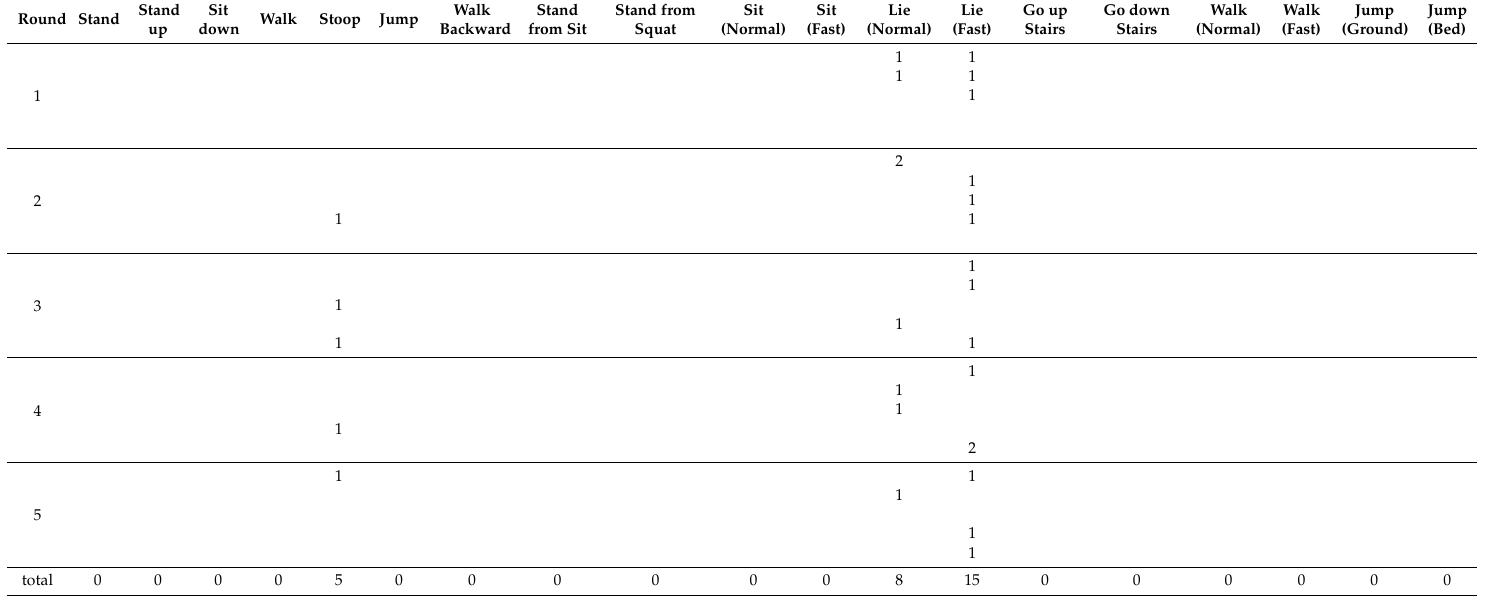
Table A2. The total testing data of false predictions for falls and ADLs using the knowledge-based